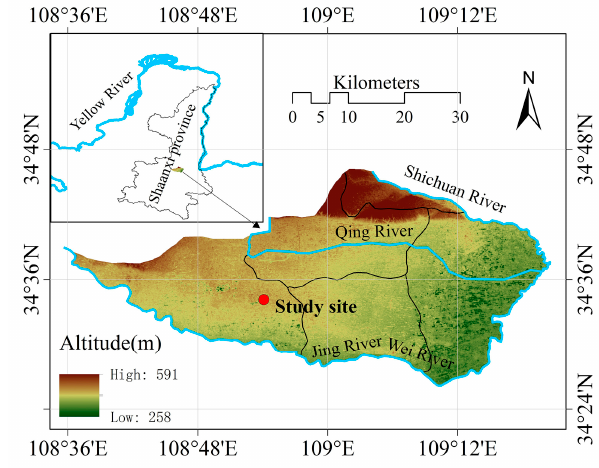
Figure 1. Location of the study site.